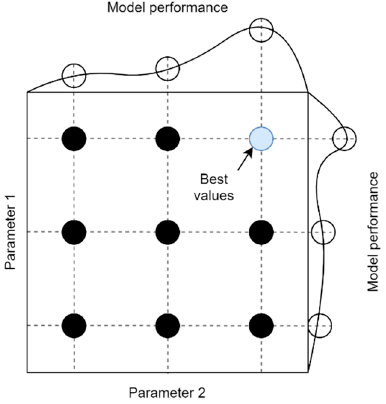
Figure 5. Example of a searching grid for two parameters.